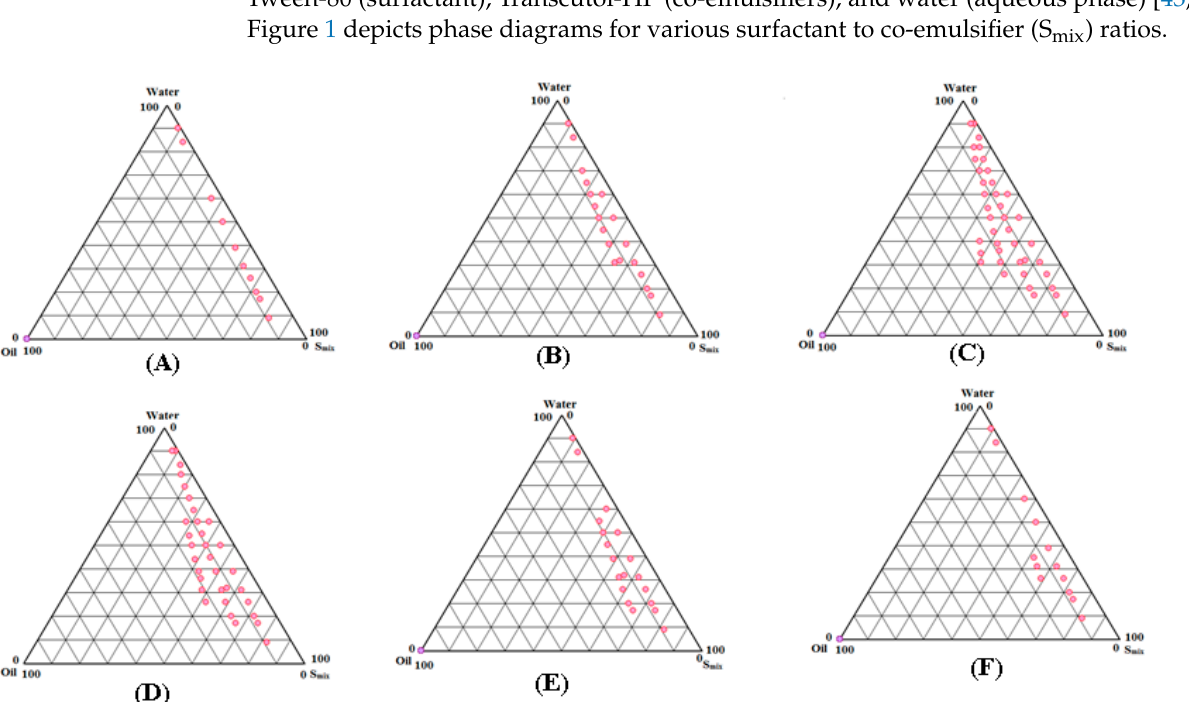
Table 1. Equilibrium solubility data of luteolin (LUT) in different excipients at 25 °C.